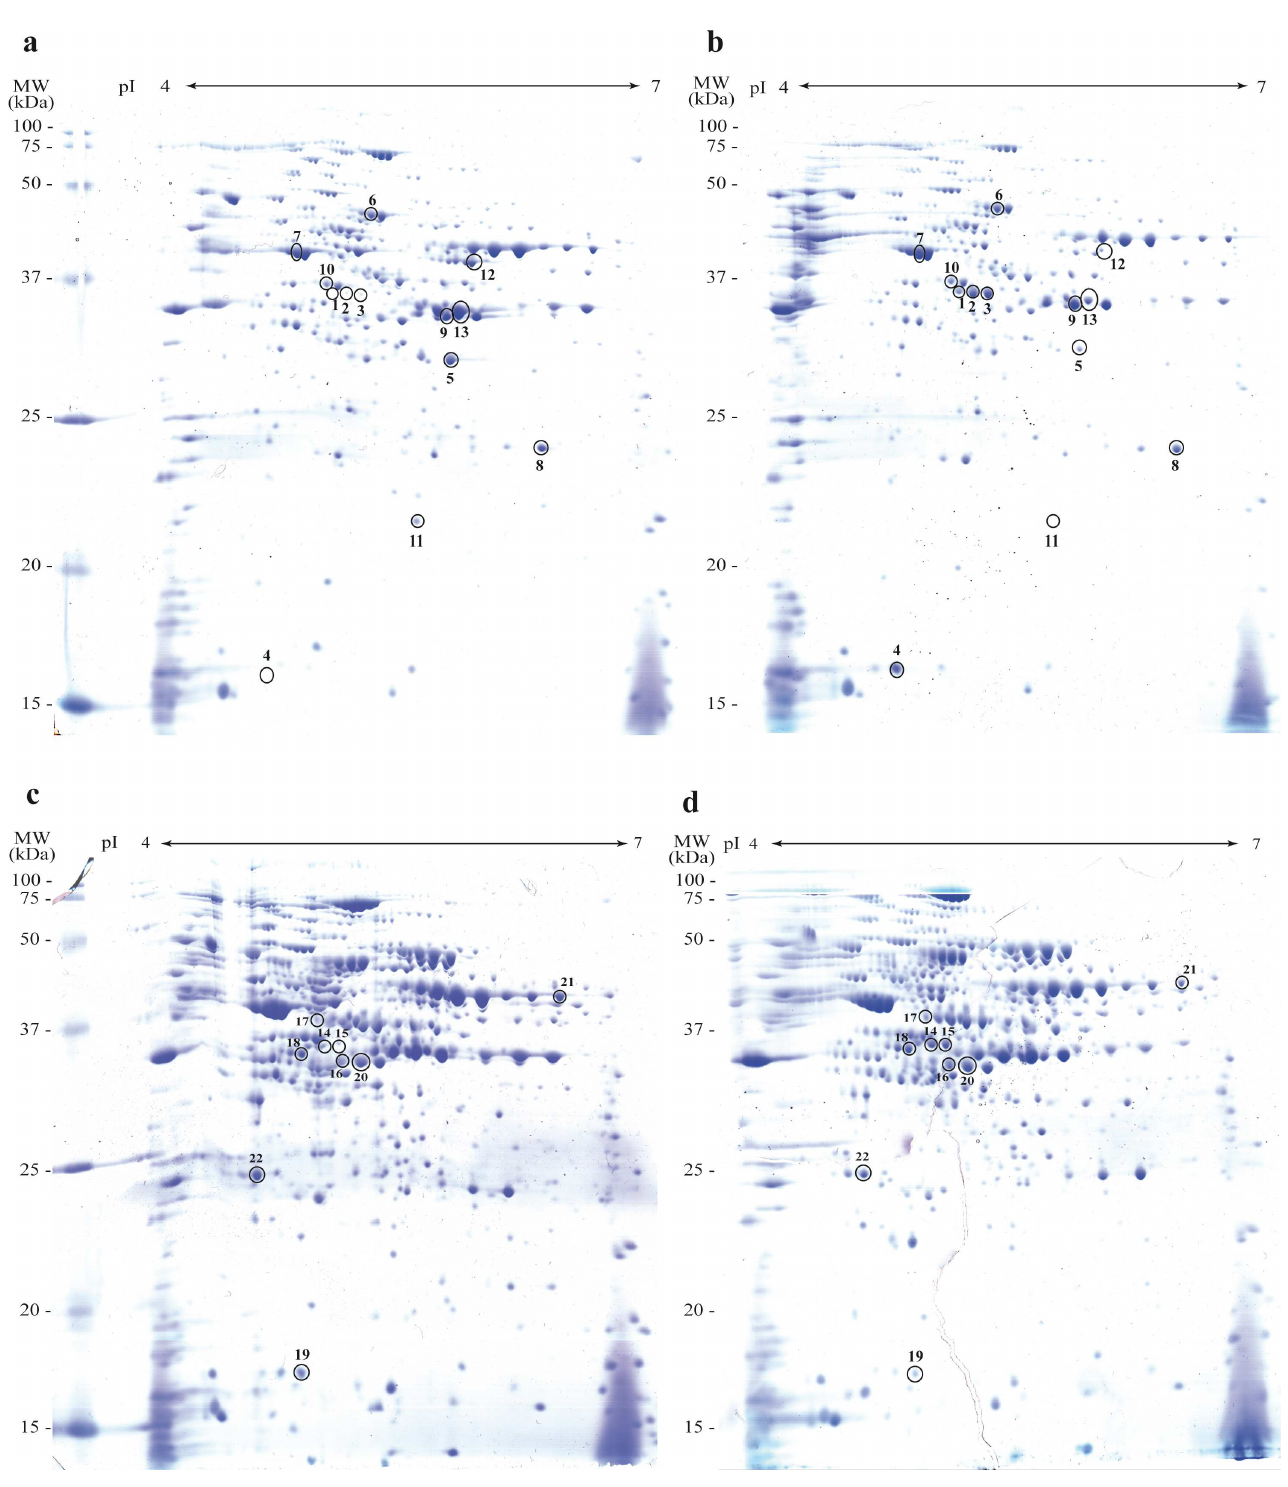
Fig 5. Representative gel images of proteomes of L . reuteri CRL 1101 obtained under the four studied conditions. a, b) 8 h of incubation in the absence(control) and in the presenceof fructose, respectively;c, d) 24 h of incubation in the absenceand in the presenceof fructose, respectively.Circles indicatethe identifiedspots by MALDI-TOF. LinearpH gradientwas